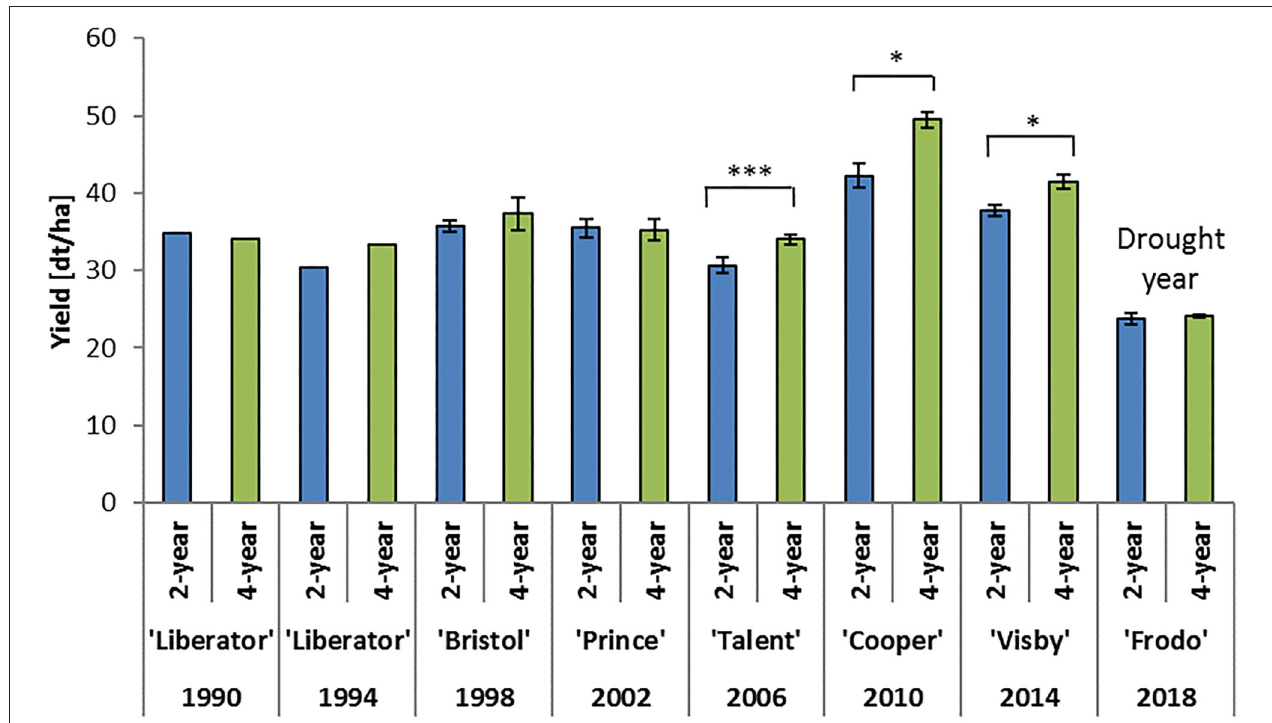
FIGURE 4 | Effect of crop rotation on yield of oilseed rape. Long-term crop rotation field experiment conducted since 1986 in Göttingen, Germany. No replication was conducted in the years 1990 and 1994. Experiment is arranged in a split-plot design with three replicates (plot size 15 × 30m). Crops are grown according to good agricultural practice, however, without any fungicides. Bars indicate standard errors. Statistical analysis was conducted with t -test in each year. 2-year, oilseed rape cultivated every second year; 4-year, oilseed rape cultivated every 4 years; -, cultivar was not recorded; * P < 0.05; *** P <